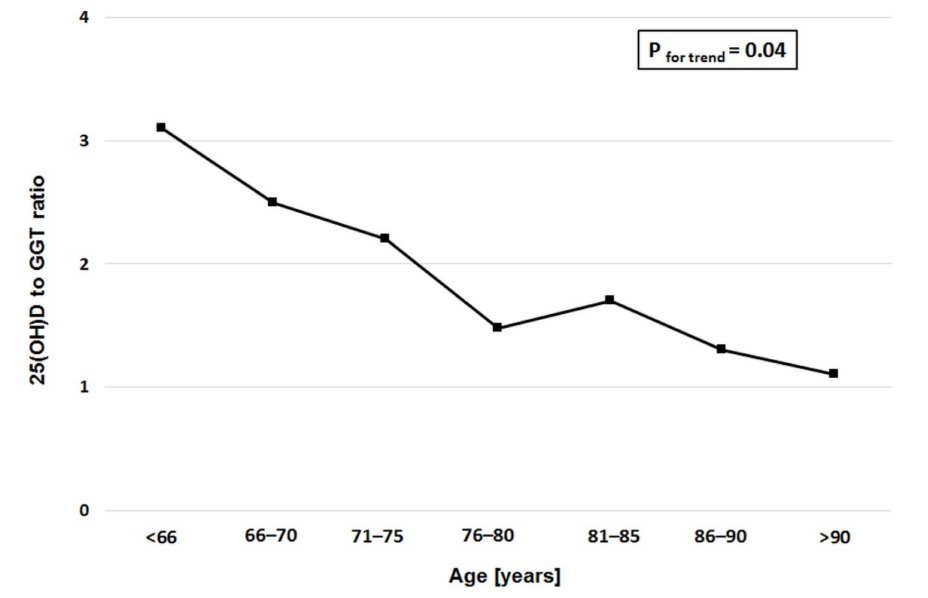
Figure 2. Age range-dependent changes in the 25-hydroxyvitamin D (25(OHD)) to gamma glutamyltransfarase (GGT)